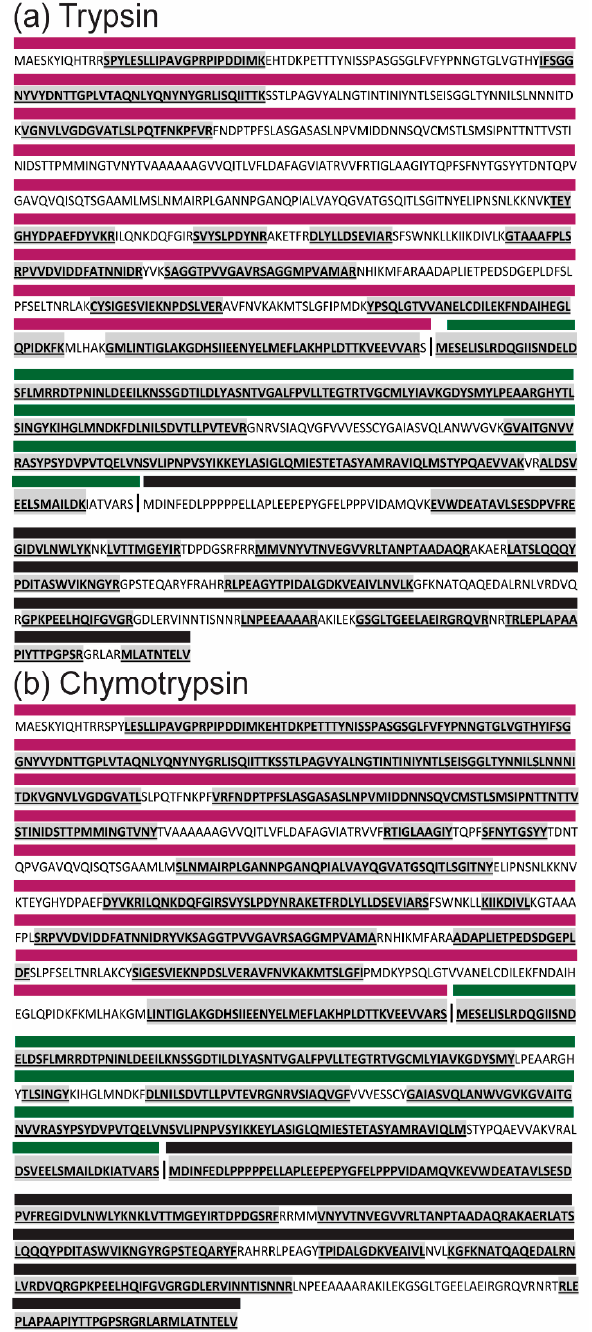
(sample 2) (Figure 7a). The anti-ABV mouse immune serum had a strong neutralizing e ff ect on ABV, inhibiting replication at all tested dilutions (1:20 to 1:2480). Viruses 2020 , 12 , x FOR PEER REVIEW